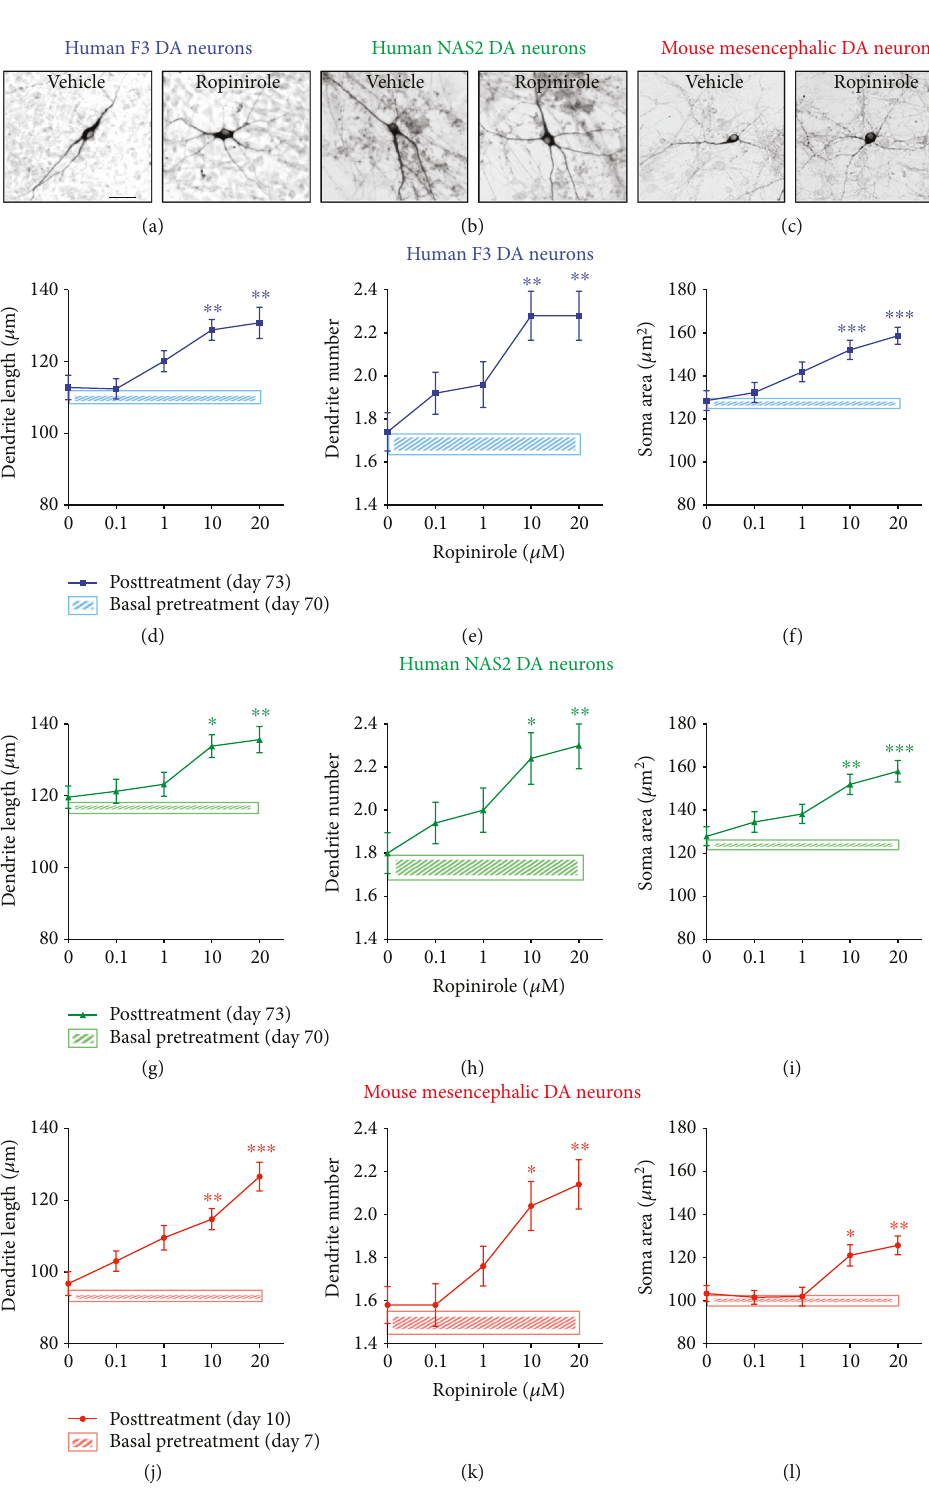
Figure 2: Ropinirole promotes structural plasticity of human iPSC-derived and mouse mesencephalic DA neurons. (a – c) Representative photomicrographs of human F3, human NAS2 (70 days in culture), and mouse mesencephalic DA neurons (7 days in culture) 72hrs after exposure to vehicle or to 10 μ M ropinirole. Scale bar: 30 μ m. (d – l) Concentration-response curves of the e ff ect of ropinirole on maximal length of dendrites, number of primary dendrites, and soma area of (d – f) human F3 DA neurons, (g – i) human NAS2 DA neurons, and (j – l) mouse mesencephalic DA neurons. Shaded areas: (d – f) light blue, (g – i) light green, and (j – l) light red show no signi fi cant changes in structural plasticity between basal measurements and measurements after 72hrs when cultures were exposed to vehicle. Data are expressed as mean ± SEM ( ∗∗∗ p < 0 001 , ∗∗ p < 0 01 , and ∗ p < 0 05 versus vehicle (0); post hoc Bonferroni ’ s